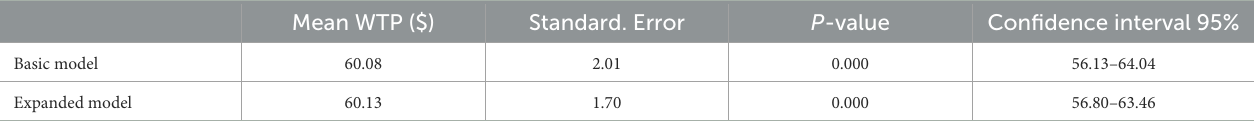
TABLE 3 Estimation of double-bounded discrete choice models and willingness-to-pay (WTP) estimates for the basic and expanded model a , 2021. Mean WTP